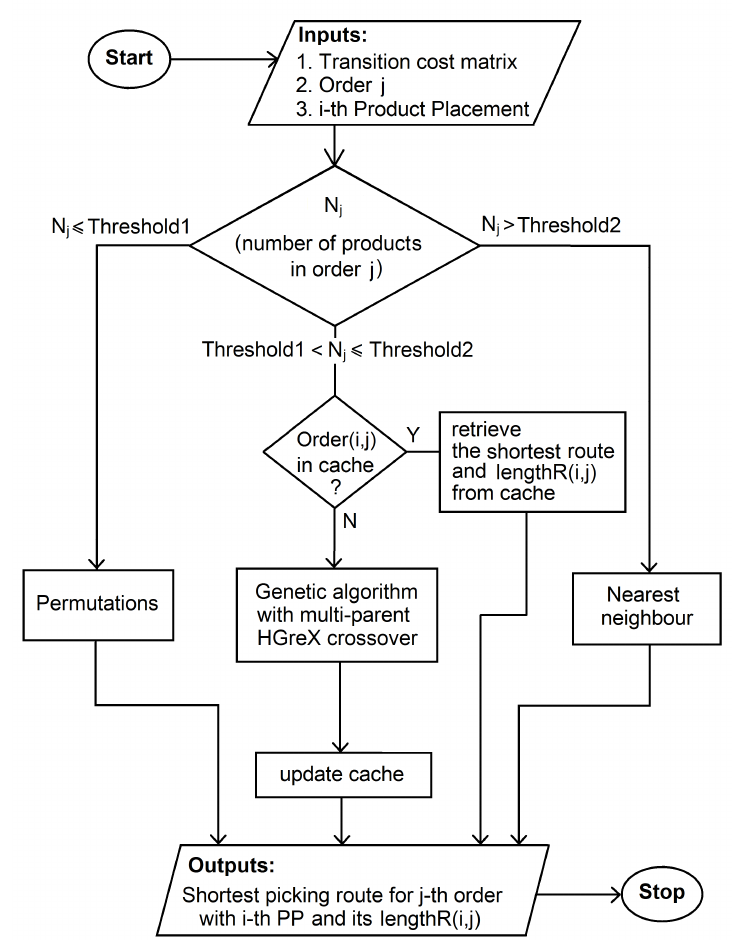
Figure 4. Order picking route